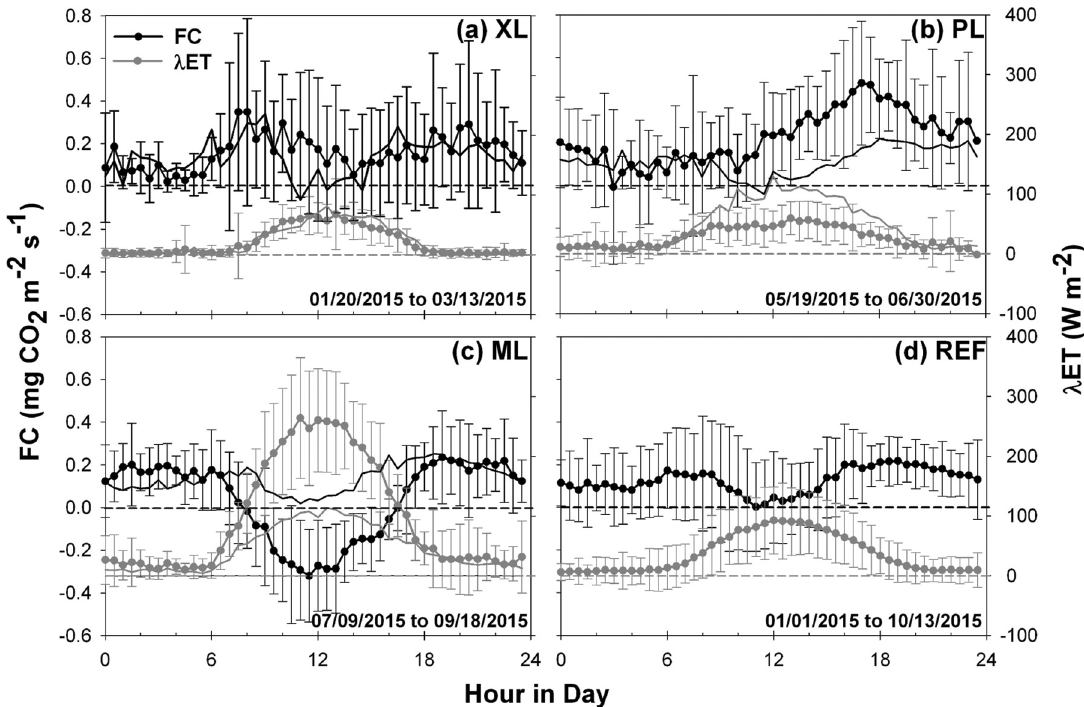
Fig 4. Diurnal averages of FC and λ ET at the four sites. Average diurnal cycle of carbon dioxide flux and latent heat flux for (a) XL, (b) PL, (c) ML, and (d) REF sites. Error bars represent one standard deviation over the indicated periods. Thin lines are average diurnal cycles at the REF site during the same period as the mobile deployment for FC (black) and λ ET (gray). Horizontal lines indicate zero values. Different sampling periods are specified in each plot.